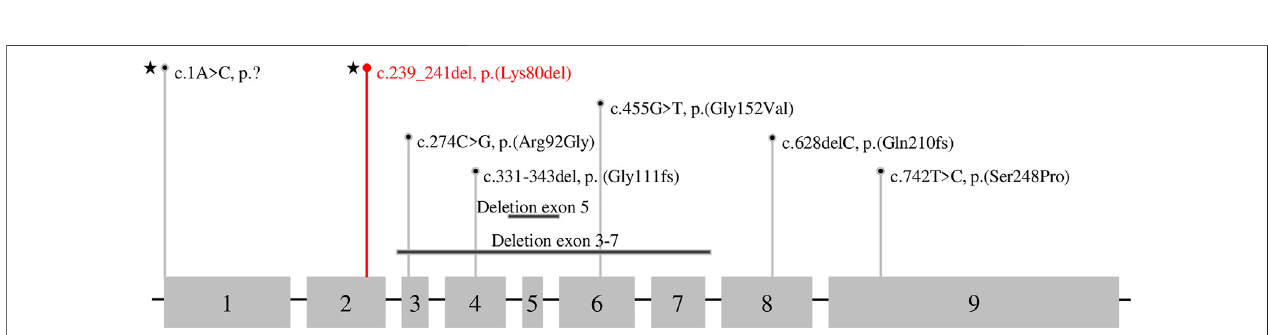
FIGURE3| VariantTypeandExonDistributionofVariantsin DPM1 .The DPM1 (NM_003,859.2,ENST00000371588.5)transcriptisshownwithnumberedexons, grey boxes illustrate the coding sequence. Variants identi fi ed in this patient are marked with a star, the novel variant is shown in red and previously reported variants are presented in